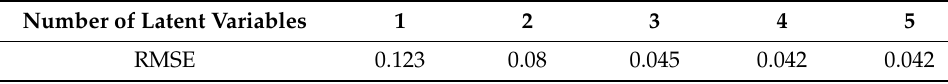
Table 4. RMSE under different latent variable dimensions.